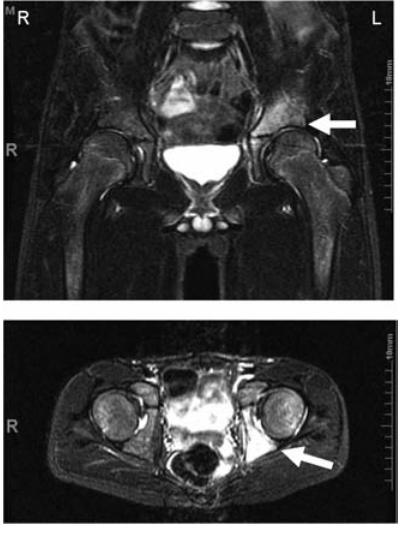
Figure 2. 67 Ga scintigraphy scanned on day 11. Increased isotope uptake by the left hip joint was observed. Arrows indicate the abnormal signal. R and L represent right and left,